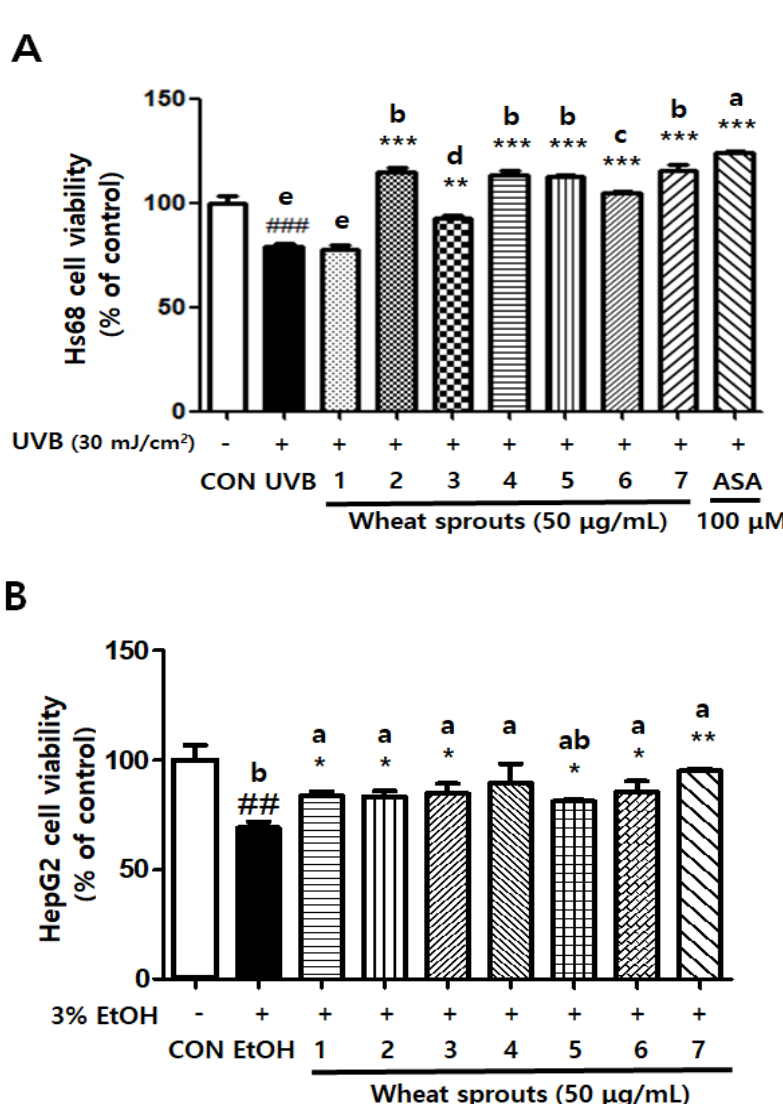
Figure 2. Effects of wheat sprouts of multiple cultivars on oxidative stress-stimulated cells. ( A ) Hs68 dermal fibroblasts exposed to ultraviolet B (UVB) irradiation (30 mJ/cm 2 ). ( B ) Hepatoma HepG2 cells were stimulated with 3% EtOH. The cell protective effects of the wheat sprouts were assessed in terms of percent cell viability. 1, ‘Heuk1’; 2, ‘Australian standard white’; 3, ‘BaekJoong’; 4, ‘Baekkang’; 5, ‘Saekeumkang’; 6, ‘Jeonju391’; 7, ‘Ariheuk’ (purple wheat). CON, untreated control; ASA, ascorbic acid. UVB- and EtOH-stimulated groups without sample treatment were compared with each of the indicated groups using independent Student’s t -test ( ## p < 0.01; ### p < 0.001 vs. untreated control group; * p < 0.05; ** p < 0.01; *** p < 0.001 vs. stimulated group with sample treatment). Different letters represent significant differences between stimulated groups ( p < 0.05; ANOVA, followed by Duncan’s multiple range test).